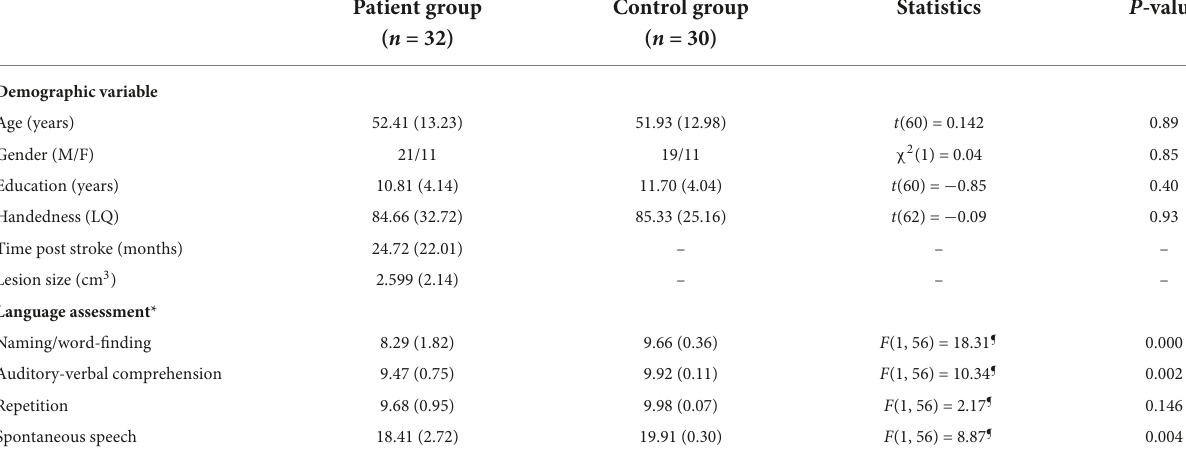
TABLE 1 Demographic details and language performance in patients and healthy